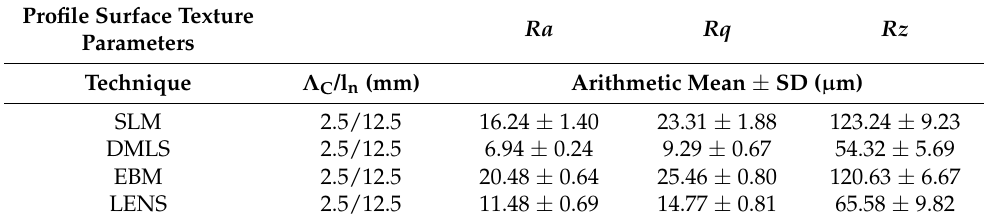
Table 3. Reference line roughness parameters of different AM techniques.